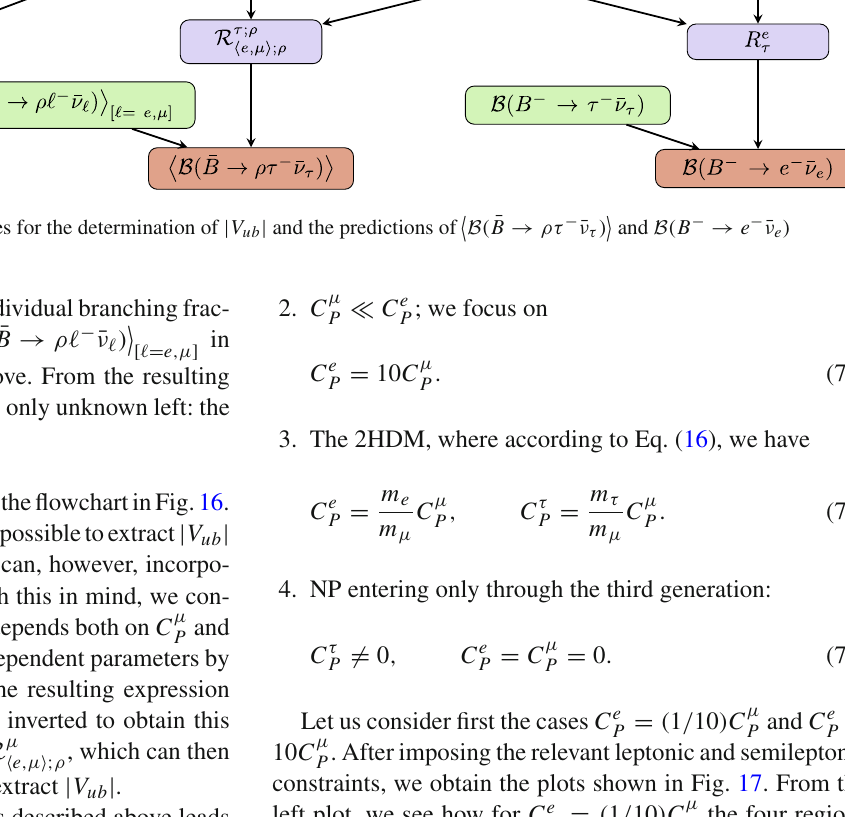
(cid:27) (cid:28) B ( ¯ B → ρτ − ¯ ν τ ) and B ( B − → e − ¯ ν e )